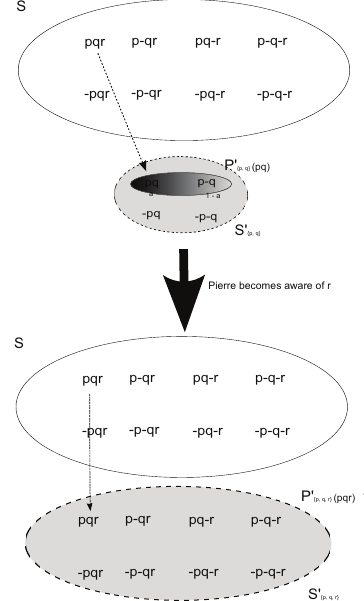
Figure 6. The issue of becoming aware.